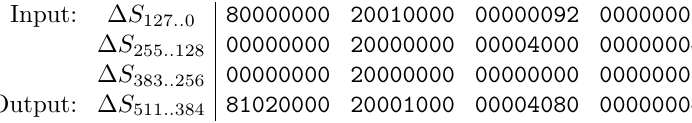
Table 9: Probability 2 − 19 Type 4 differential trail for 384 rounds found with the refined model.